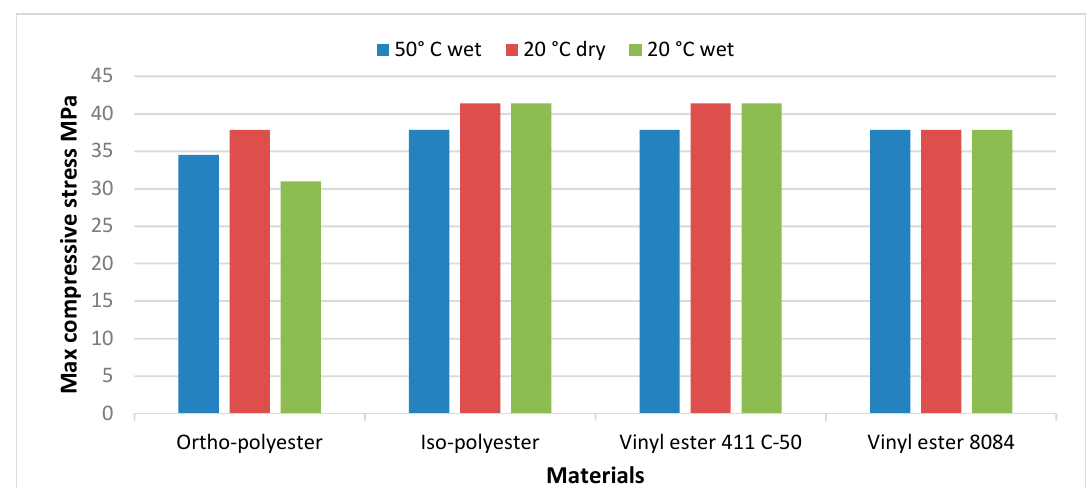
Figure 15. Fatigue strength comparison of all resins investigated.